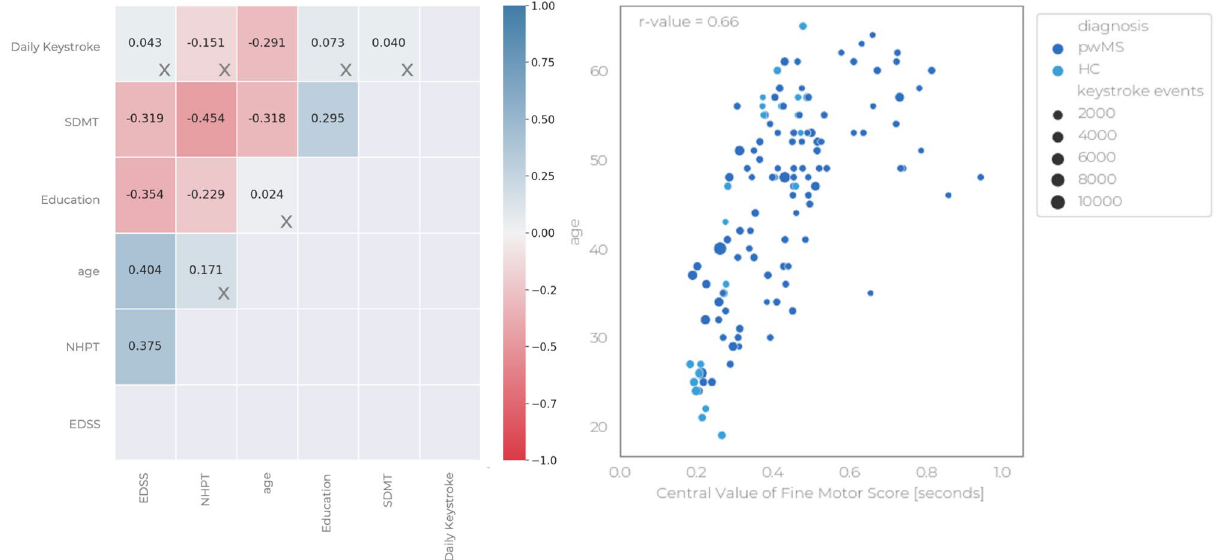
Figure 7. On the left is the correlogram relative to the clinical outcomes actual score measured at baseline, the corresponding daily keystroke events averaged within a two-week time window centred at m 00, and the numerical demographics variables. A cross in the bottom-right quadrant denotes a non-significant r value with p value > 0.05. One can observe a non-negligible linear relationship between clinical outcomes and demographic variables. On the right is the scatter-plot between age and the most recurring composite score, i.e. the central value of the fine motor score, collected at baseline for both HC and pwMS within the same time range as previously mentioned. The dot size is tuned based on the average daily keystroke event. For the sake of visualization, the x -axis was set between 0 and 1 second, though an additional instance was recorded from an MS patient with pair ( x = 1.68, y = 59 ) and average daily keystroke event count equal to